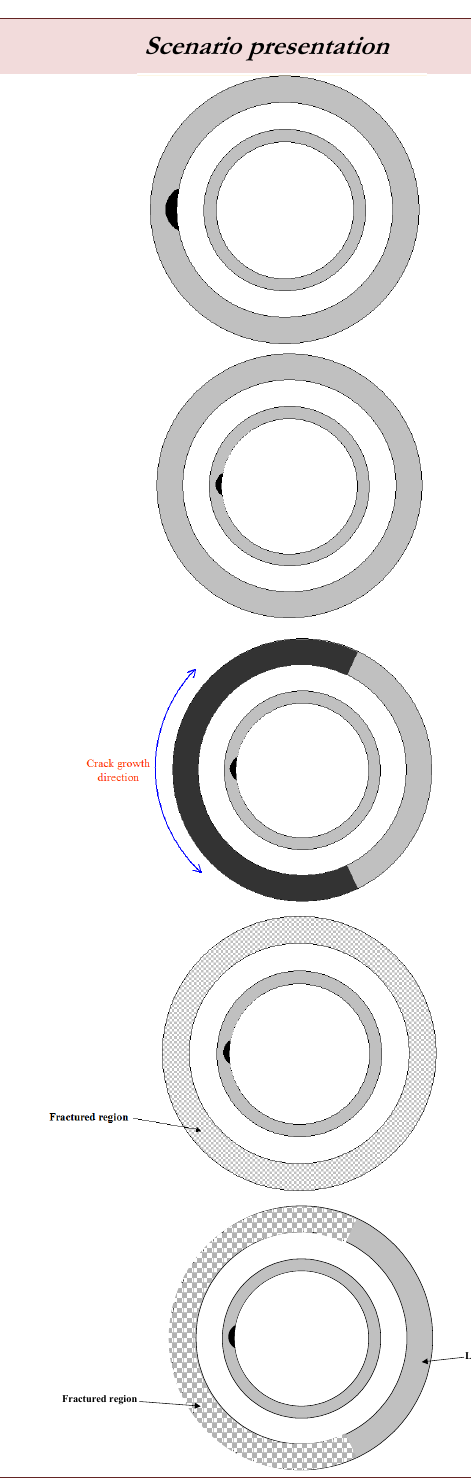
Table 10: Studied